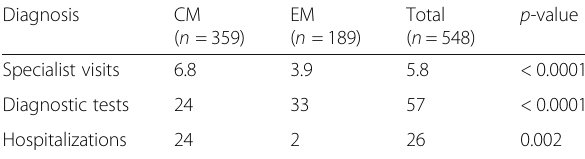
Table 2 Healthcare resource use in 2 years by migraine status Diagnosis